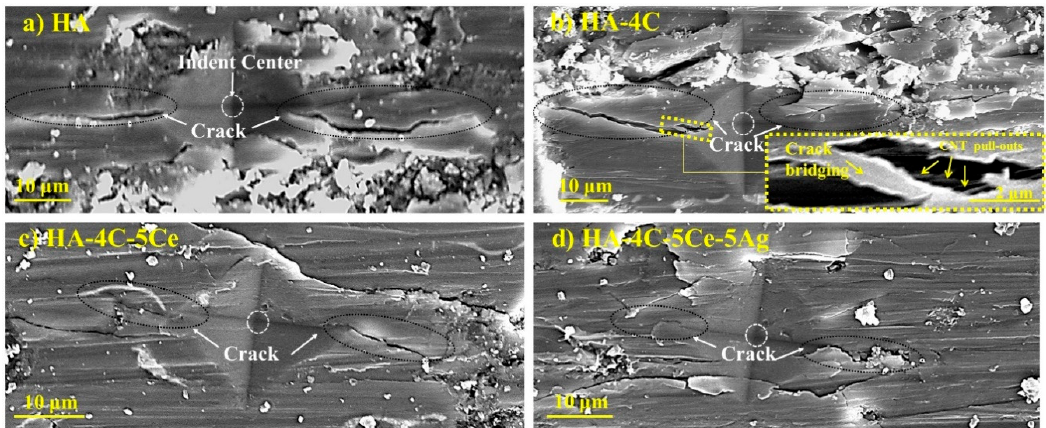
Figure 3. Propagating radial crack from the indent in plasma sprayed coatings of ( a ) HA, ( b ) HA-4C (inset depicting the crack showing CNT pull-outs and crack bridging phenomenon), ( c ) HA-4C-5Ce, and ( d ) HA-4C-5Ce-5Ag.